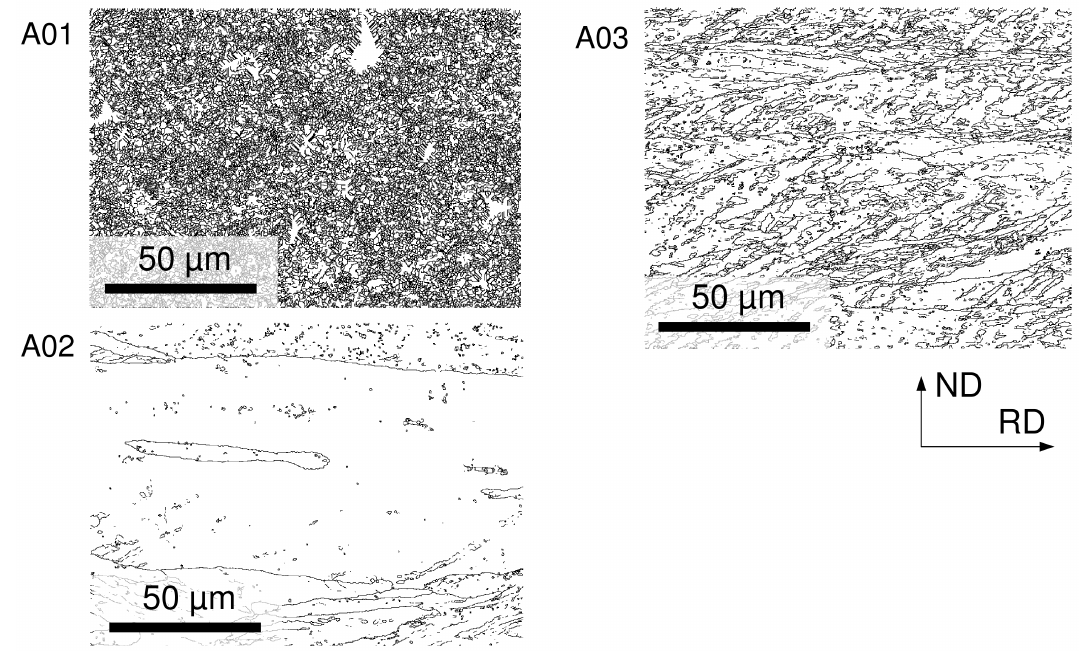
Figure 1. Grain boundary maps of Al, prepared by DSR. A01: one rolling pass, speed ratio: 1:1; A02: 1 rolling pass, speed ratio: 3.0; A03: four rolling passes, speed ratio: